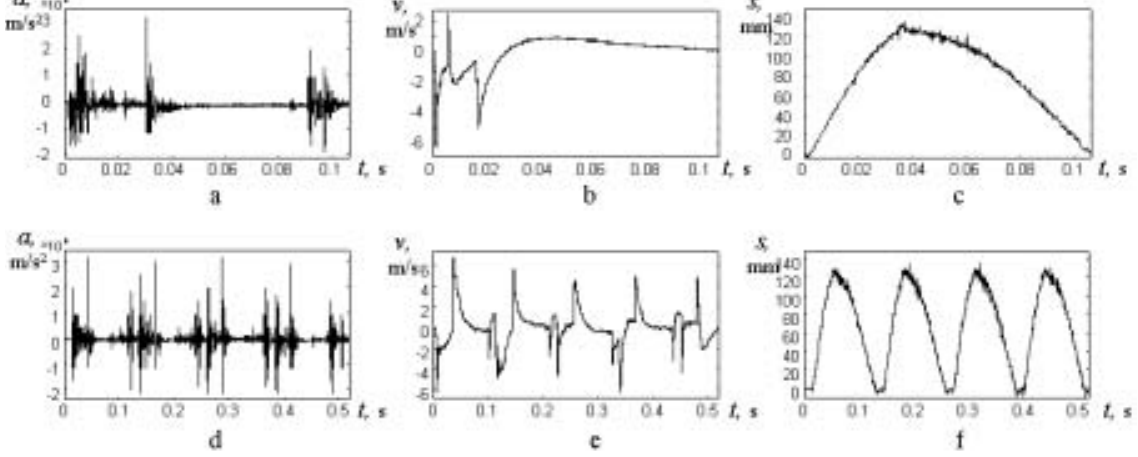
Fig. 2. Experimental characteristics of dynamic parameters of the lock movement of AK-47S gun: acceleration (a), velocity (b), displacement (c) of a storm carabine in single shot mode, and acceleration (d), velocity (e), displacement (f) in serial shot